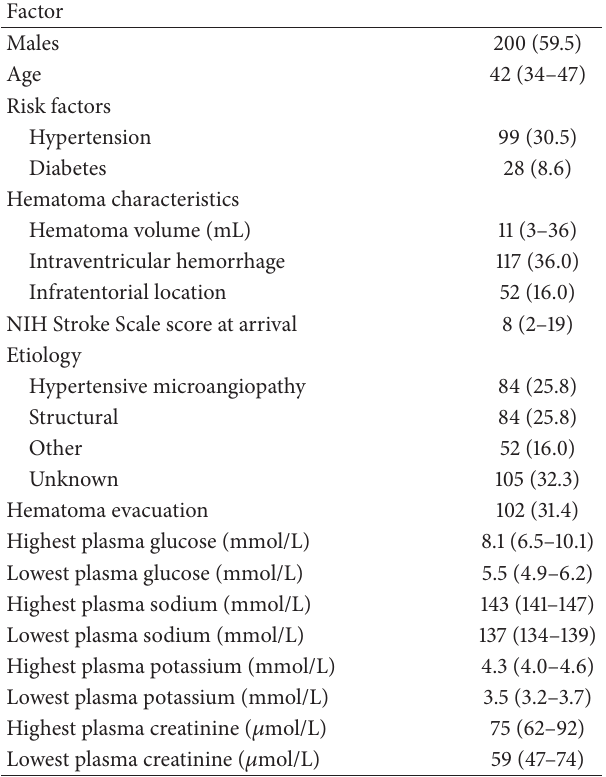
Table 1: Baseline characteristics of young ICH patients treated in Helsinki University Central Hospital between January, 2000, and March, 2010 ( 𝑁 = 325